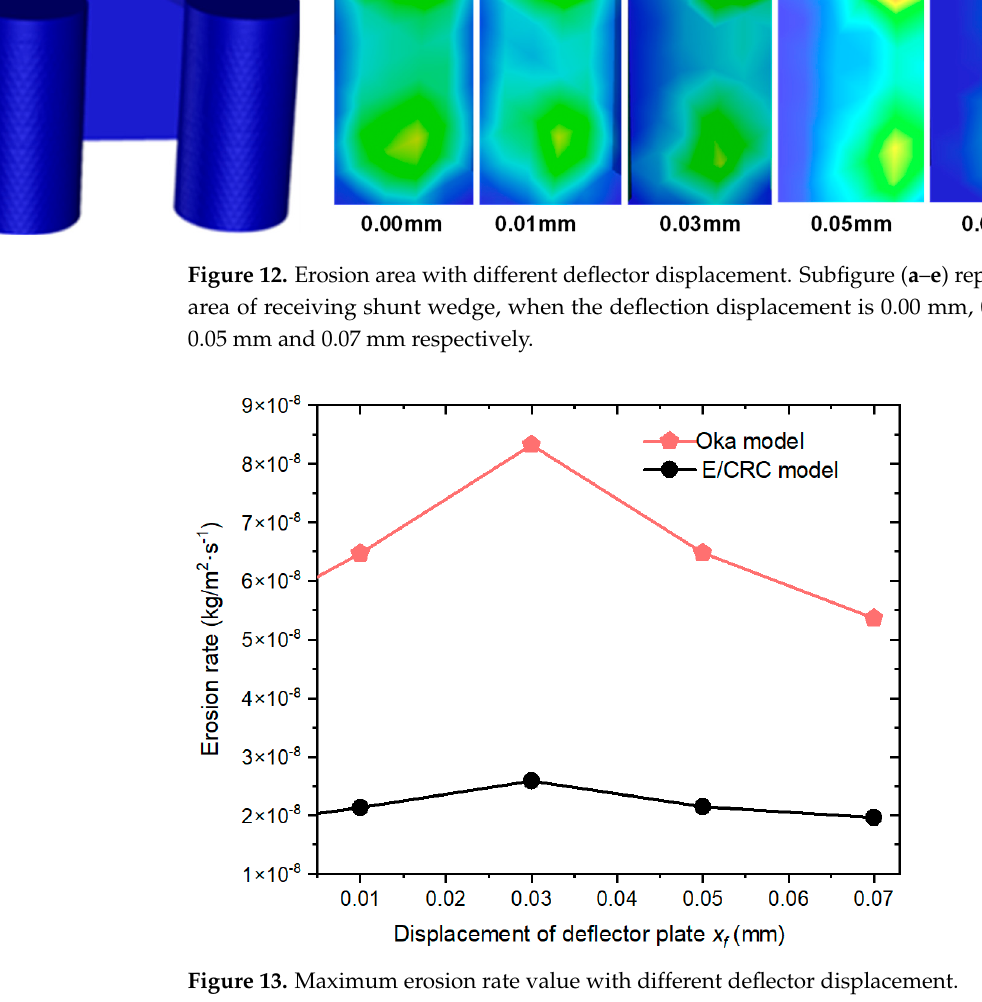
Figure 13. Maximum erosion rate value with different deflector displacement.